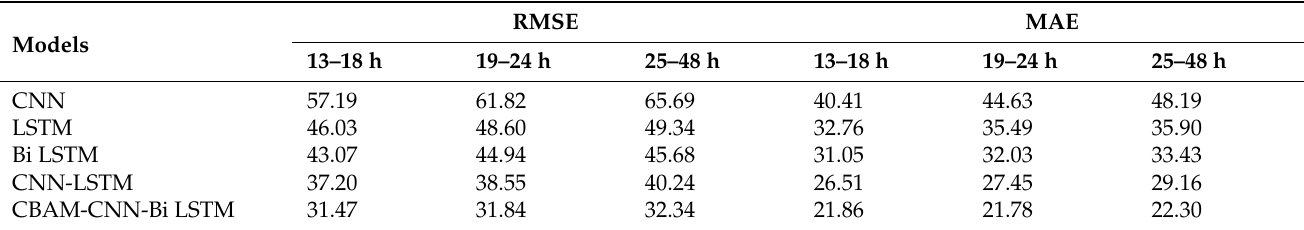
Table 7. Testing error for model prediction (h13–h48).